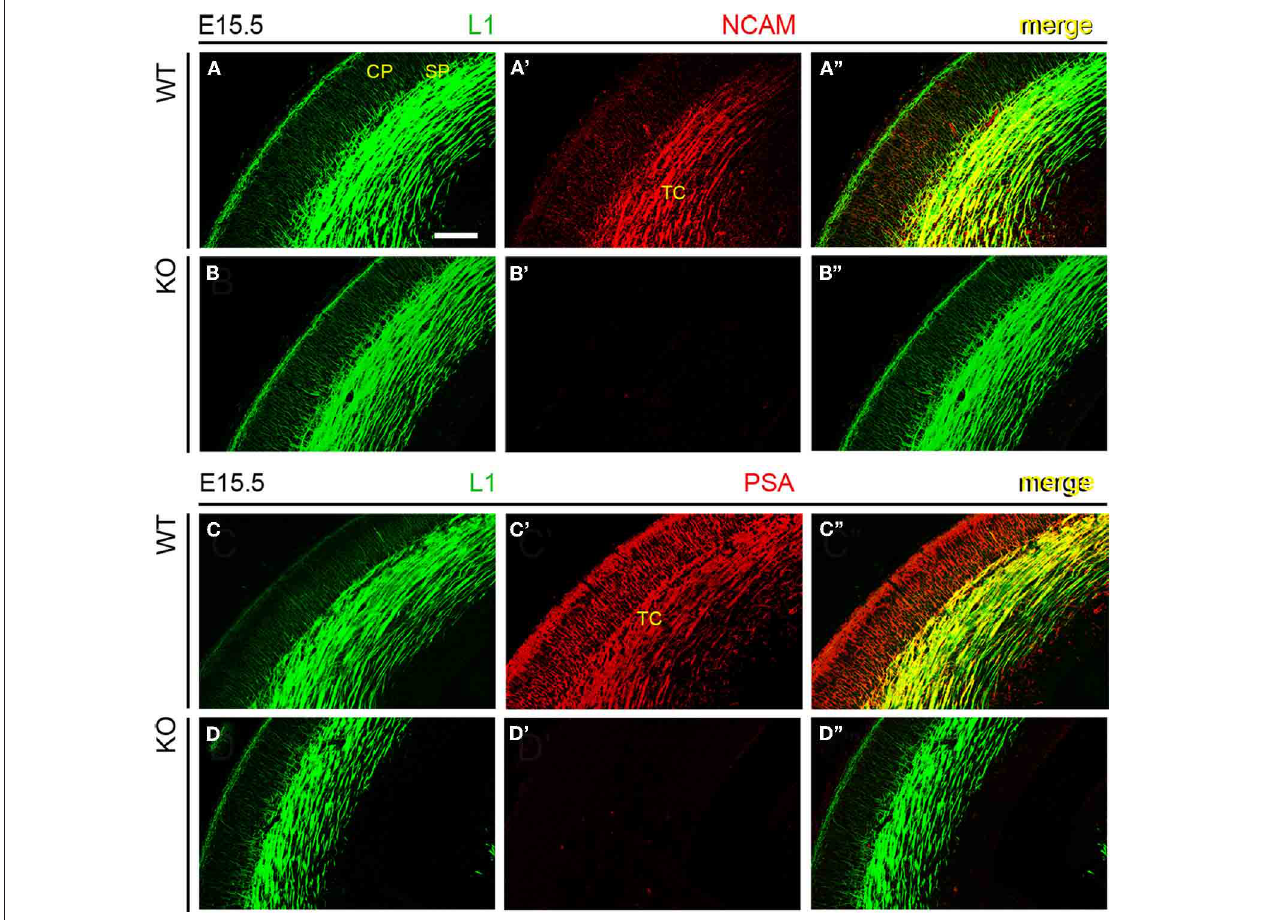
chains of PSA in L1-immunoreactive TC axons. (D–D”) Absence of PSA-NCAM immunoreactivity in NCAM null mutant mice. The absence of NCAM (B”) and PSA (D”) immunoreactivities in null mutant mice suggested that, under our experimental conditions, NCAM is the sole carrier of polysialic acid in the developing cortex. Single confocal optical sections. CP, cortical plate; SP, subplate; TC, thalamocortical axons. Bar: 200 μ